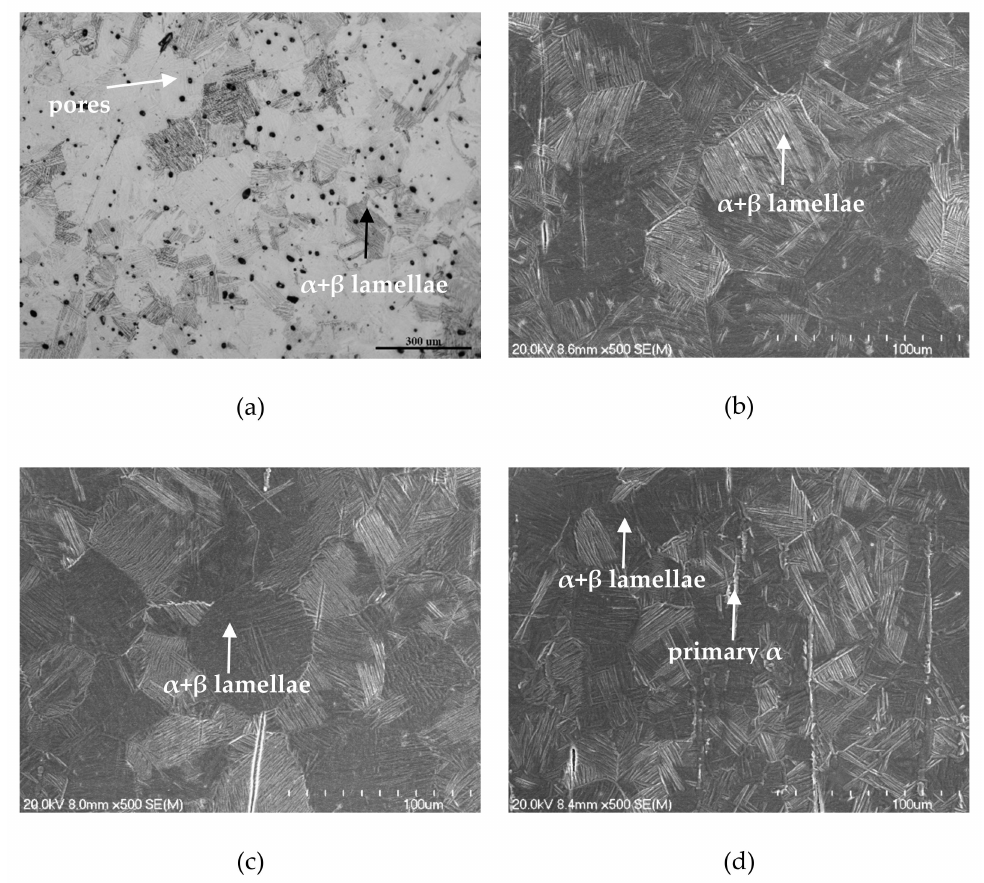
Figure 1. Microstructures of the powder metallurgy (PM) Ti-5Fe alloys: ( a ) sintered, ( b ) extruded at 900 ◦ C, ( c ) extruded at 850 ◦ C, and ( d ) extruded at 800 ◦